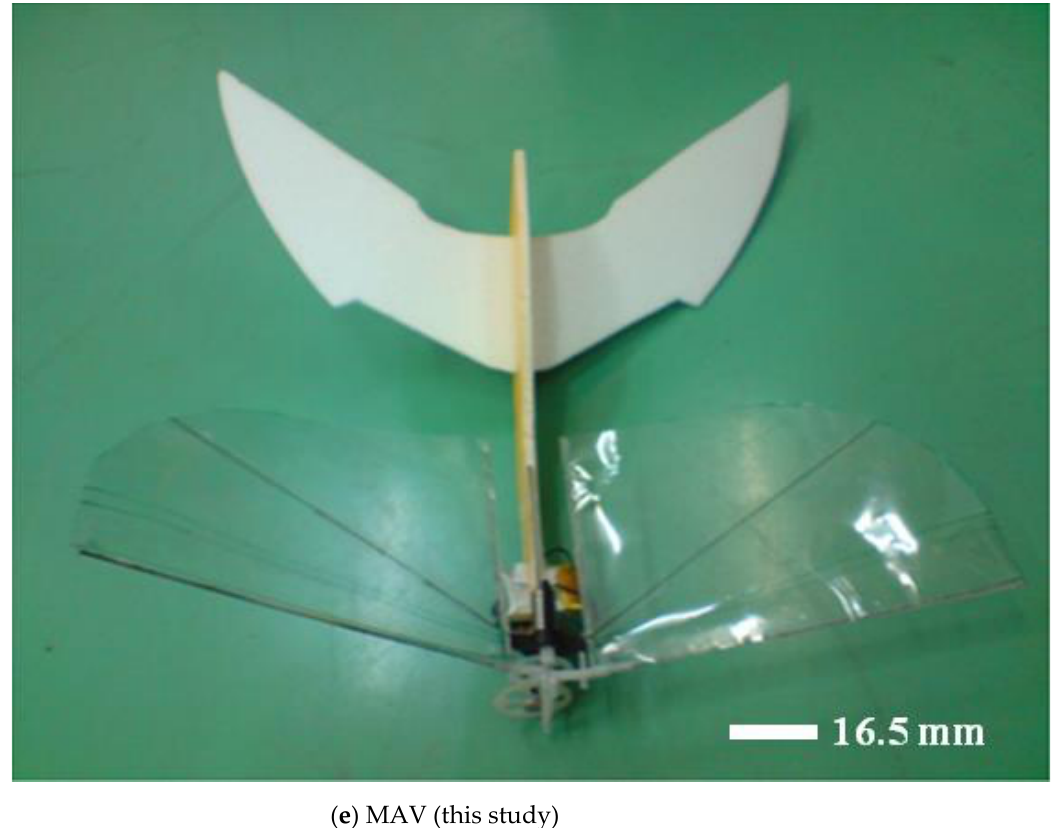
Figure 8. The real product for transmission structures of the flapping-wing MAV.